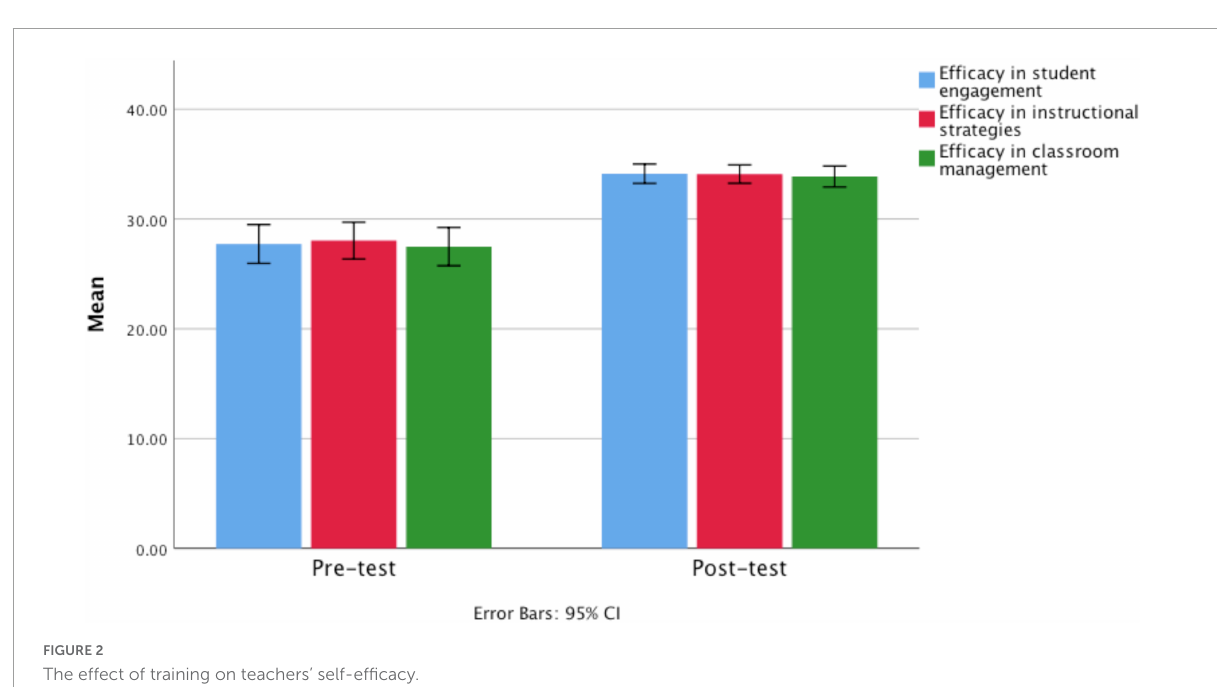
FIGURE1 The effect of training on teachers’ self-perceived knowledge and skills.